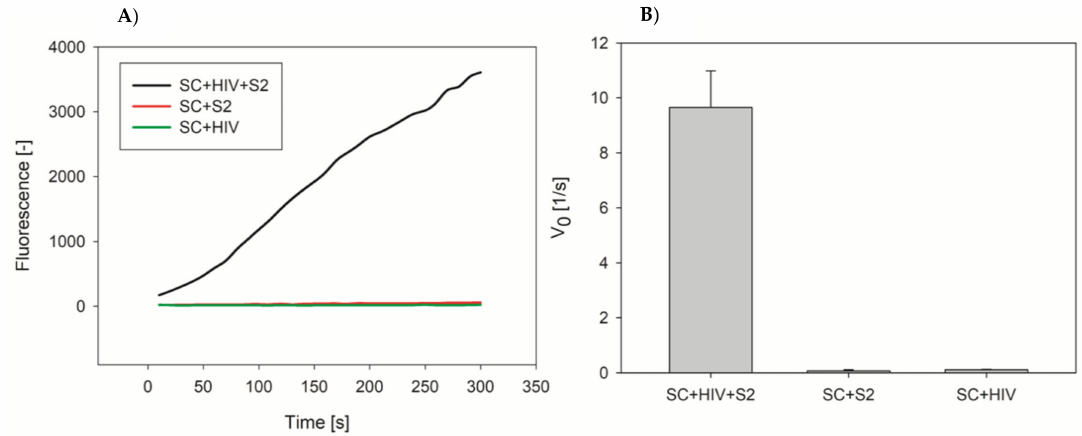
Figure 5. Kinetic plots for resorufin fluorescence generated from the Amplex Red oxidation reaction catalyzed by DNAzyme with covalently attached hemin molecule in a “sandwich” assay for detection of HIV DNA sequence ( A ) and initial velocity for the reaction with HIV DNA and negative probes ( B ). Conditions: 5 µ M SC, 50 nM HIV DNA, 1 µ M S2, 100 mM KCl, 10 mM Tris-HCl, 0.05% Tween 20, 1 µ M Amplex Red, 1 mM H 2 O 2